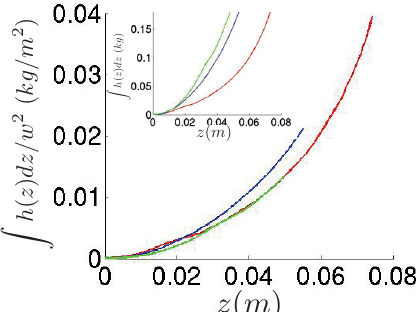
(cid:2) Figure 5. Inset: h ( z ) dz versus z of s = 1 intruder, varying width w : 1.9cm, 3.0cm, and 3.8cm. Lower w decreases the curve, but, in this case, the trend in data is not a ff ected. Main panel: When scaled as a function of w , the data collapse to a single curve.